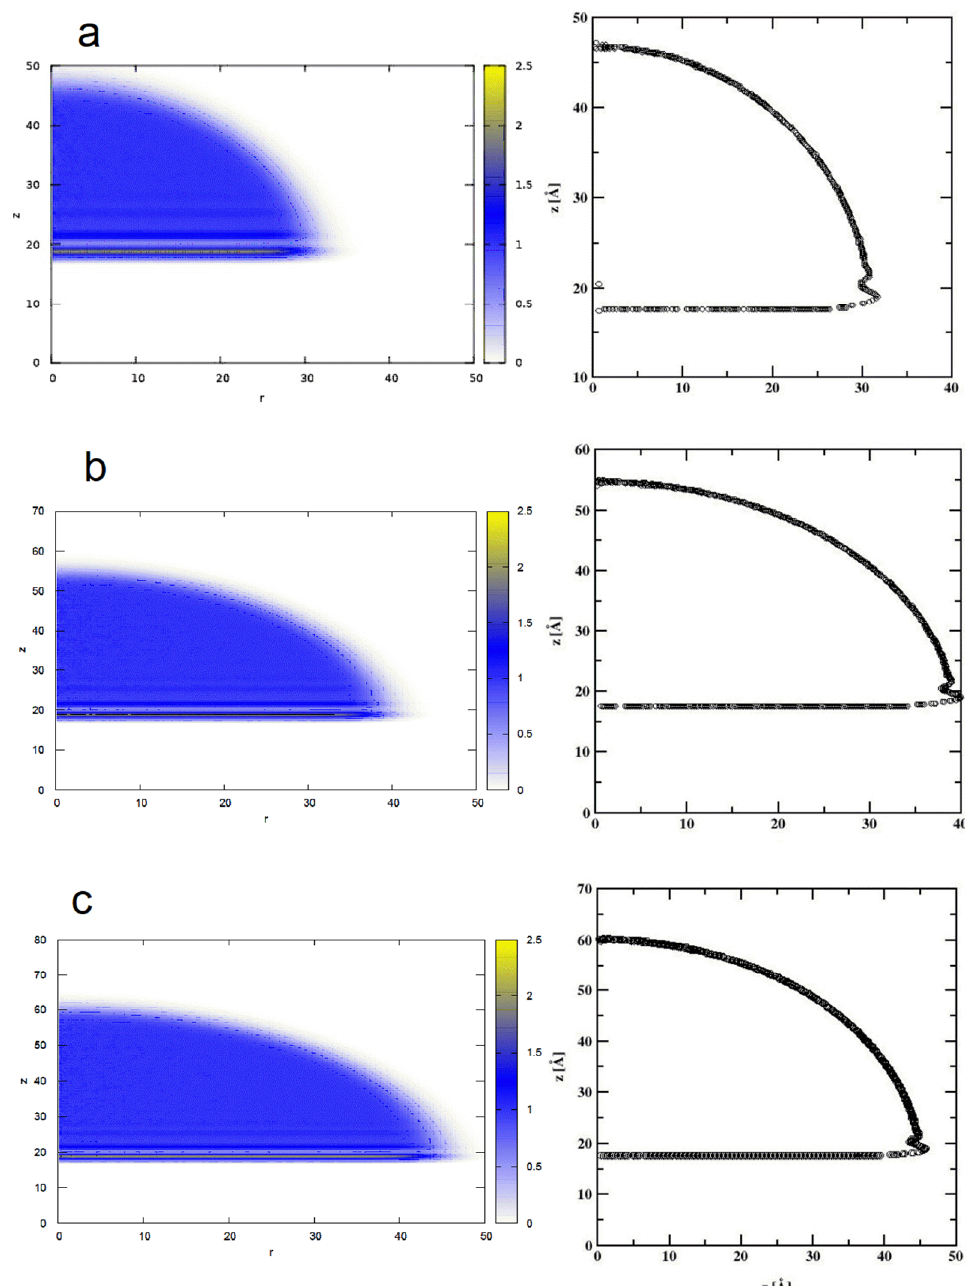
Figure 5. Map of the mass density profiles (left column) and the spherical droplets contours (right column) of water droplet on bare silicon surface, for the droplets consisting of 2000 ( a ), 4000 ( b ), and 6000 ( c ) water molecules. The circles denote the position of water density profile with value 0.5 ± 0.03 g / cm 3 .